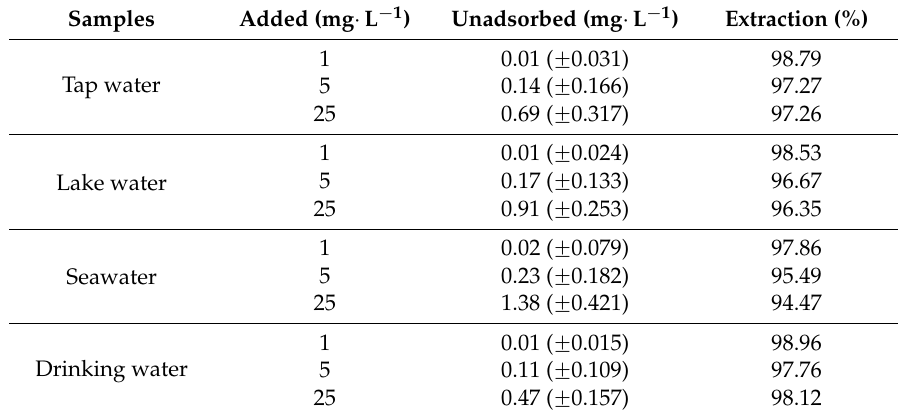
Table 3. Determination of Zr(IV) at various concentrations (1.0, 5.0 and 25.0 mg ¨ L ´ 1 ) in real